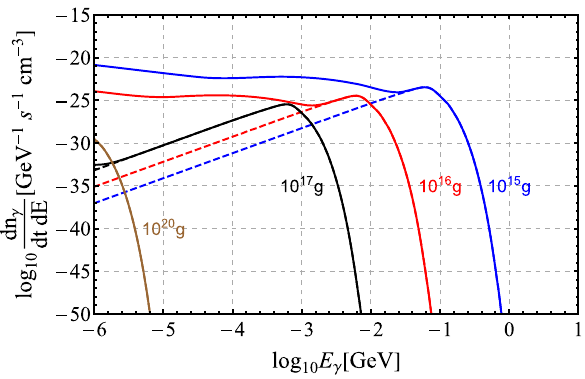
Fig. 8 Instantaneous emission rate of photons per physical cm 3 from PBHs with various horizon masses: 10 15 , 10 16 , 10 17 , 10 20 g, and the corresponding current energy fraction is set to ˜ f PBH = 1. The dashed andthesolidlinesrepresenttheinstantaneousprimaryandtotal(primary +secondary)emissionrates,respectively.Weusedtheopensourcecode BlackHawk [55] to calculate the above photon radiated